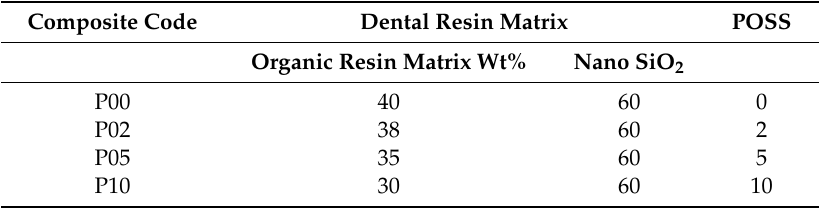
Figure 1. The molecule structure of methacryl polyhedral oligomeric silsesquioxane (POSS). Table 1. The proportion of POSS hybrid inorganic dental composite resin.